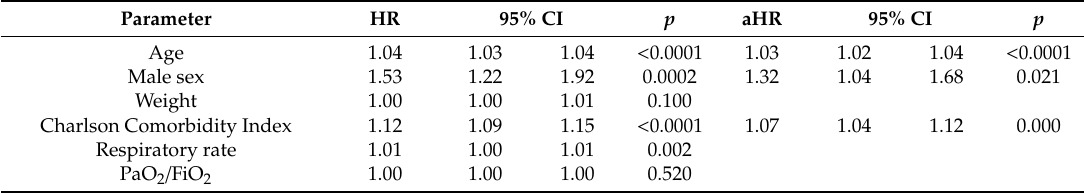
Table 3. Crude (HR) and adjusted hazard ratio (aHR) for death and intensive care unit (ICU) admission of clinical and laboratory factors at first clinical presentation in the study